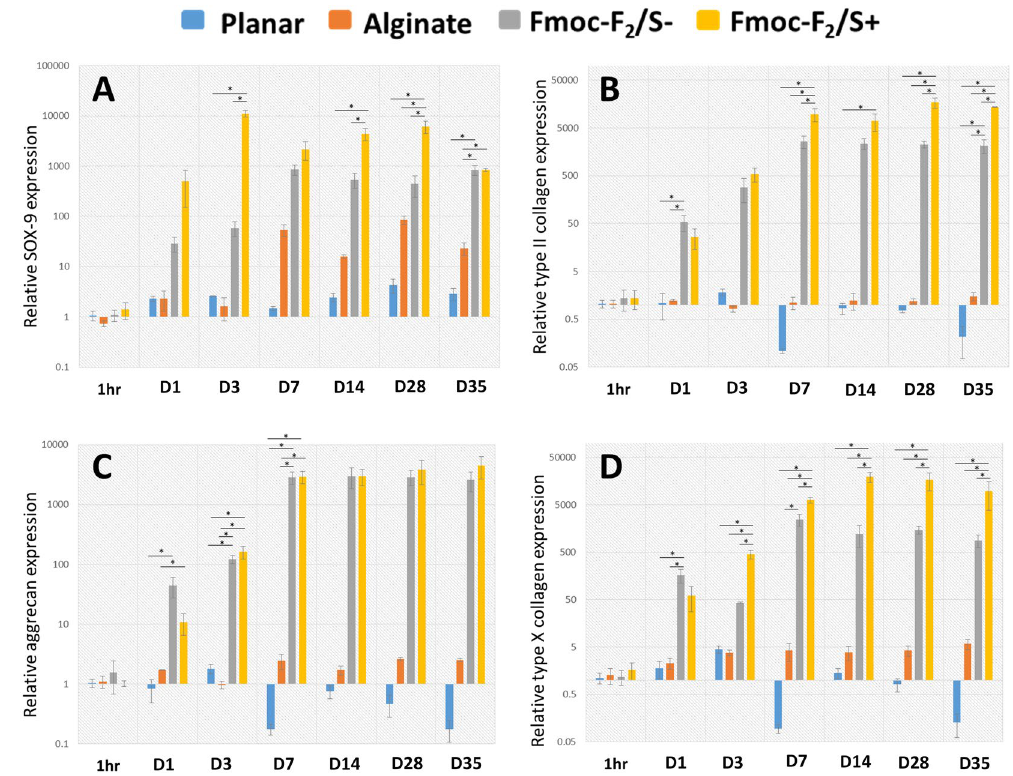
Figure 3. Quantitative PCR analysis assessing chondrocyte development of pericytes encapsulated in Fmoc- F 2 /S hydrogels with ( + ), without ( − ) chondrogenic induction and in alginate hydrogels (ALG) also cultured with chondrogenic induction media. Cells were assessed for gene expression of the cartilage biomarkers SOX-9 ( A ), type II collagen ( B ), aggrecan ( C ) and type X collagen ( D ) up to 35 days in culture. Expression levels of all four biomarker were observed as elevated for all culture systems with the highest expression levels